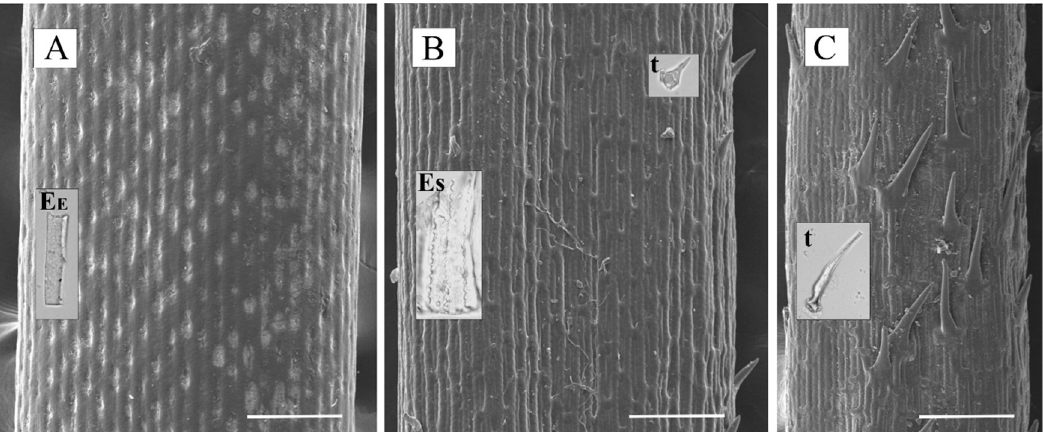
Figure 9. SEM pictures of the abaxial leaf surfaces: ( A ) F. vaginata ( B ) F. pseudovaginata ( C ) F. tomanii